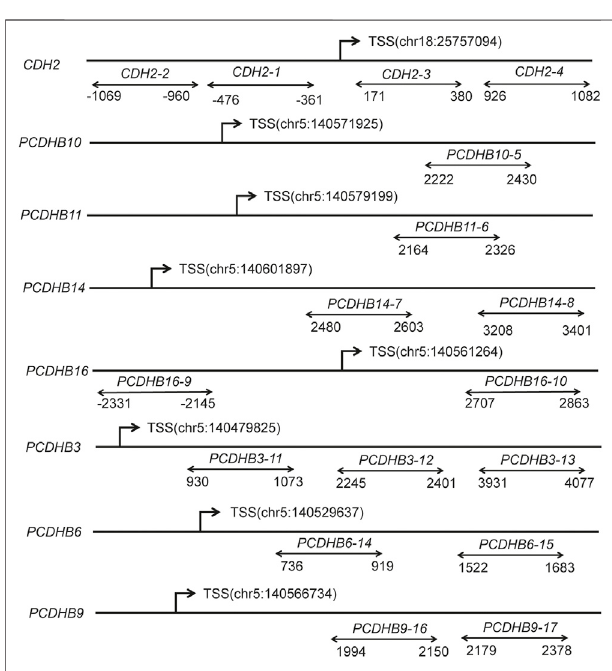
FIGURE2| Diagramofthestructure ofthe8genesand17CpGislands. Thelinerepresentsthegene,anddoublearrowsrepresentCpGislands.CpG,